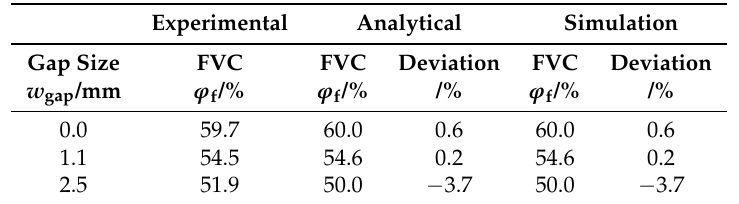
Table 3. Comparison of fiber volume content results for gapped preforms with n L = 3 (each layer consists of gapped and a fixed layer) and an assumed laminate thickness of t = 1.87mm. Experimental